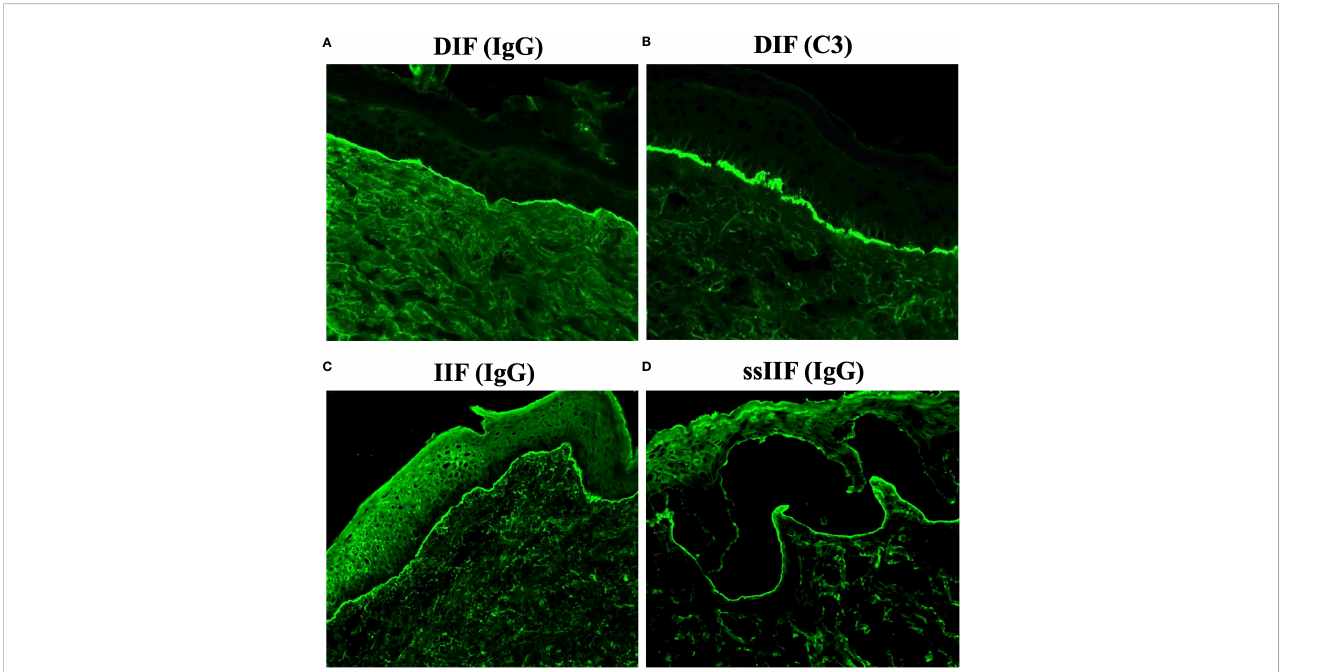
FIGURE 1 Representative results of various immuno fl uorescence tests for anti-p200 pemphigoid. (A, B) Direct immuno fl uorescence (DIF) for IgG (A) and C3 (B) . (C) Indirect immuno fl uorescence of normal human skin (IIF) for IgG. (D) Indirect immuno fl uorescence of 1M NaCl-split normal human skin (ssIIF) for IgG. All these representative results were originated from an anti-p200 pemphigoid patient with mucosal